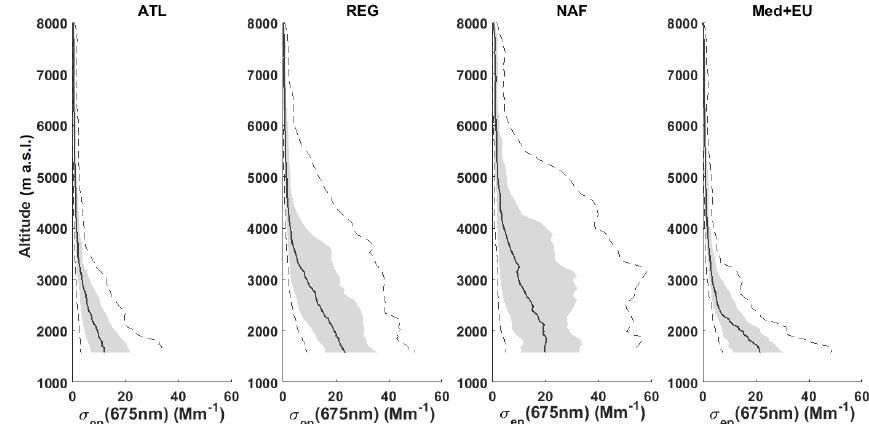
Figure 6. Particle extinction coefficient profiles at 675nm classified by air mass origin (ATL: Atlantic, REG: Regional, MED+EU: Mediter- ranean and European, NAF: North African). The line represents the median and the shadowed area is the interquartile range. The dashed lines represent the 10th and 90th percentiles. Statistics are based on daily average profiles.